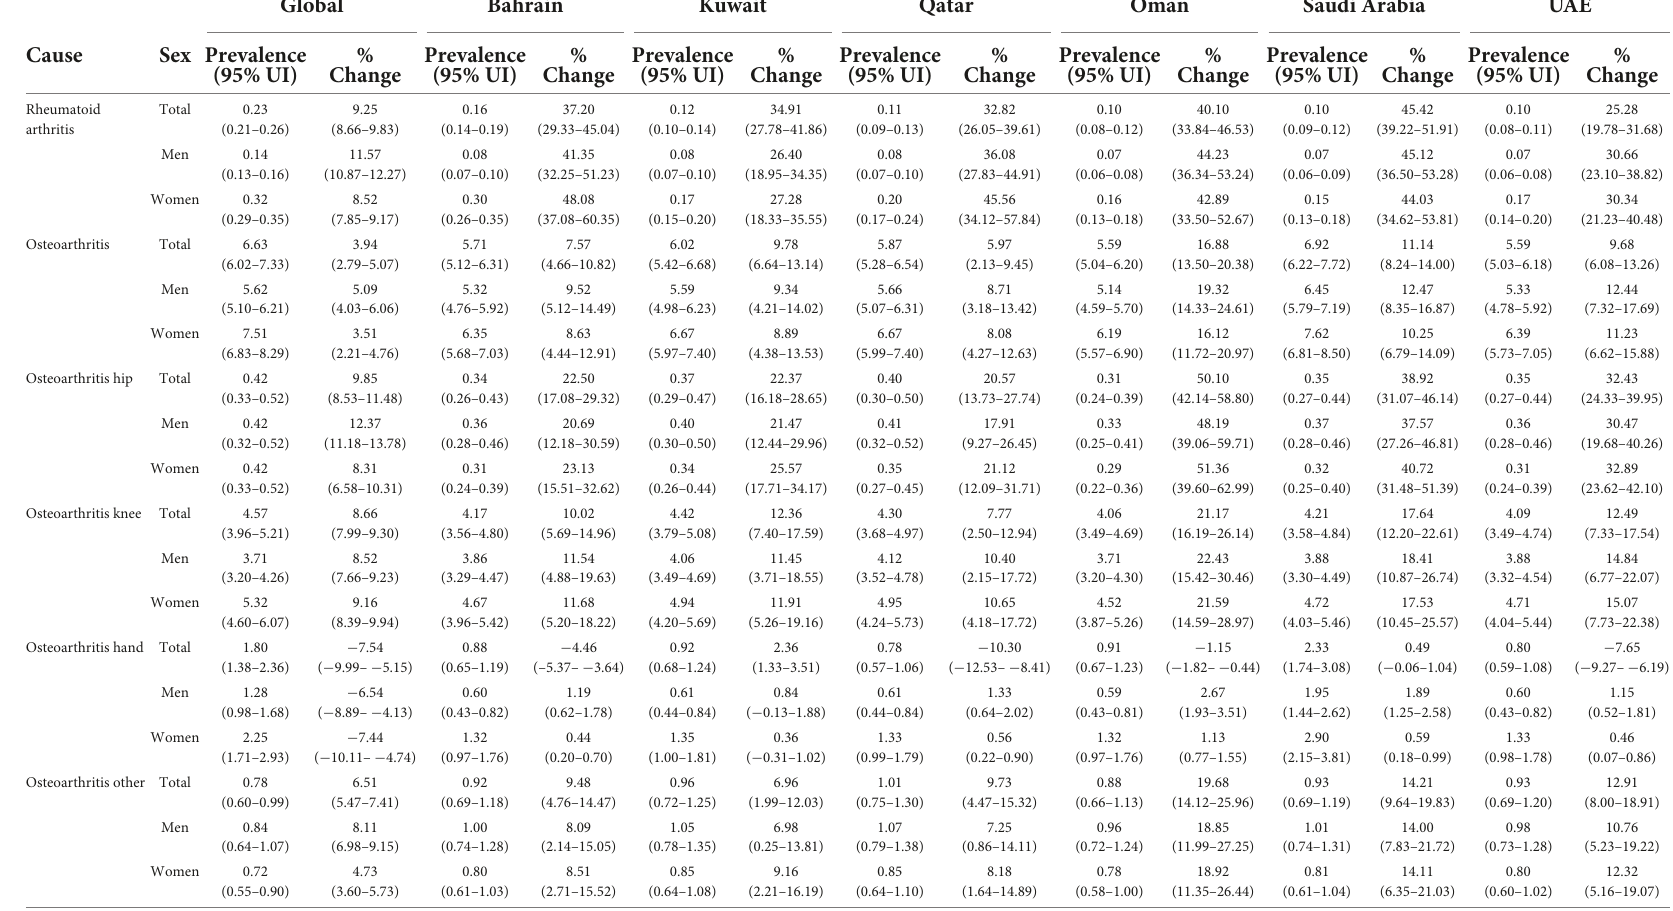
TABLE 3 Age-standardized prevalence (%) for different MSK disorders in the GCC countries in 2019 and the percentage change between 1990 and